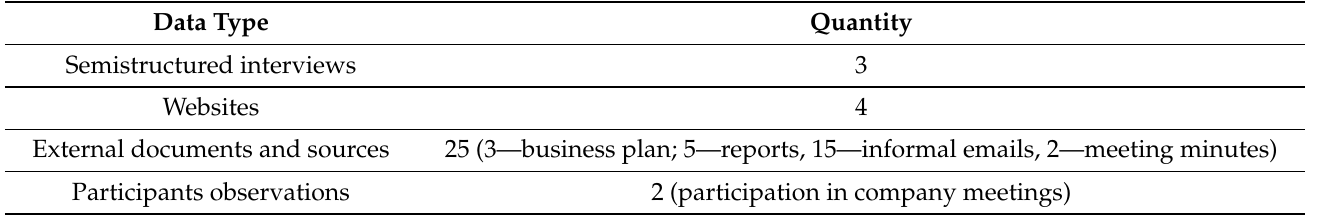
Table A1. Summary of collected data: all